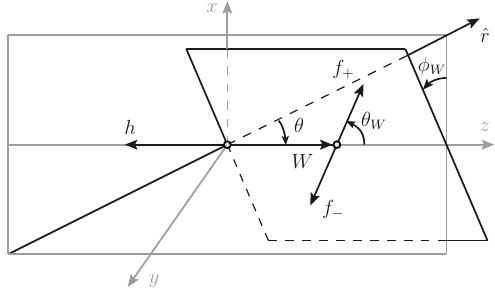
Figure 2 . Scattering and decay angles. f